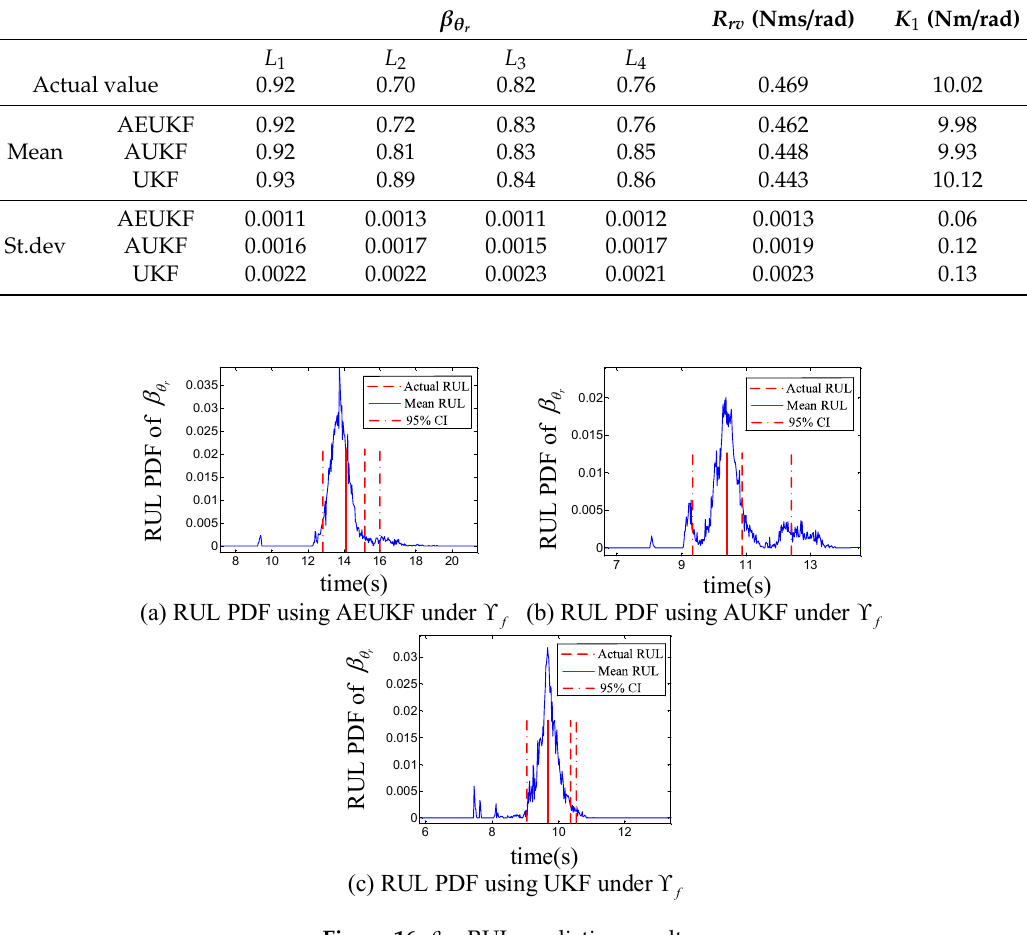
Figure 16. 𝛽 (cid:3087)(cid:3045) RUL prediction results. Figure 16. β θ r RUL prediction